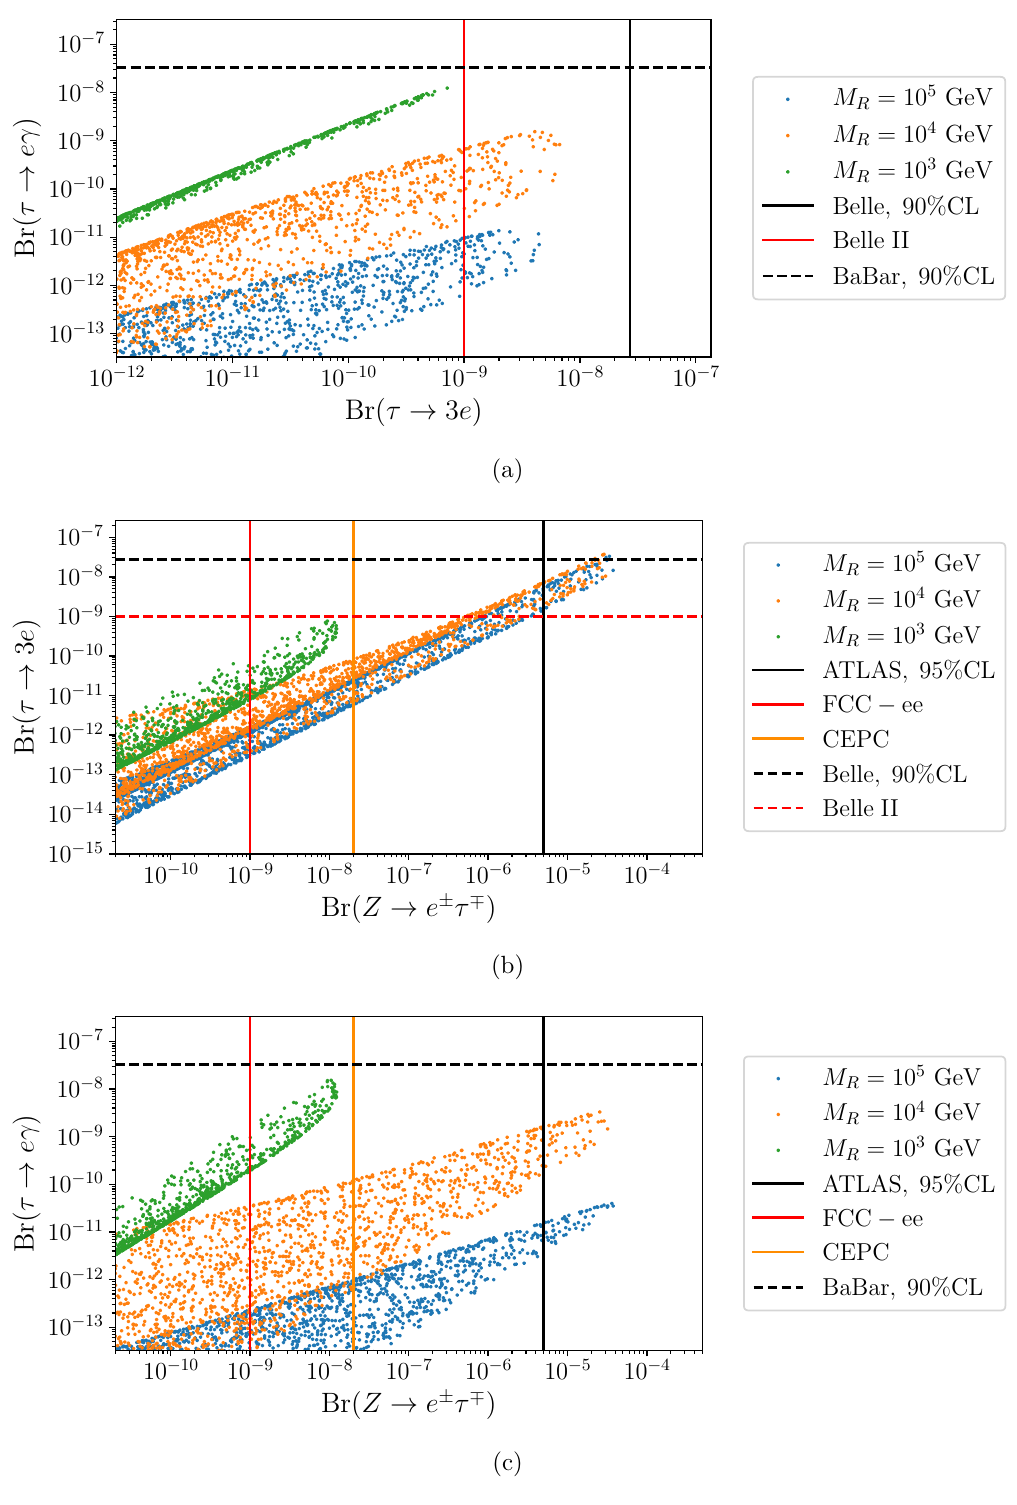
Figure 13. Correlations between the processes τ → 3 e , τ → eγ and Z → eτ . The current experimental upper limits are indicated by the black lines while the future sensitivities are shown in red and